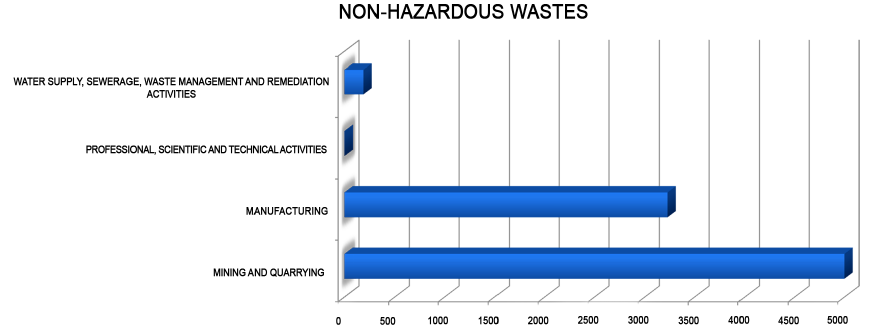
Figure 6. Non-hazardous waste (NHW) flows by sector [tons] (source: CNR-IMAA elaboration on data from ARPA Basilicata).